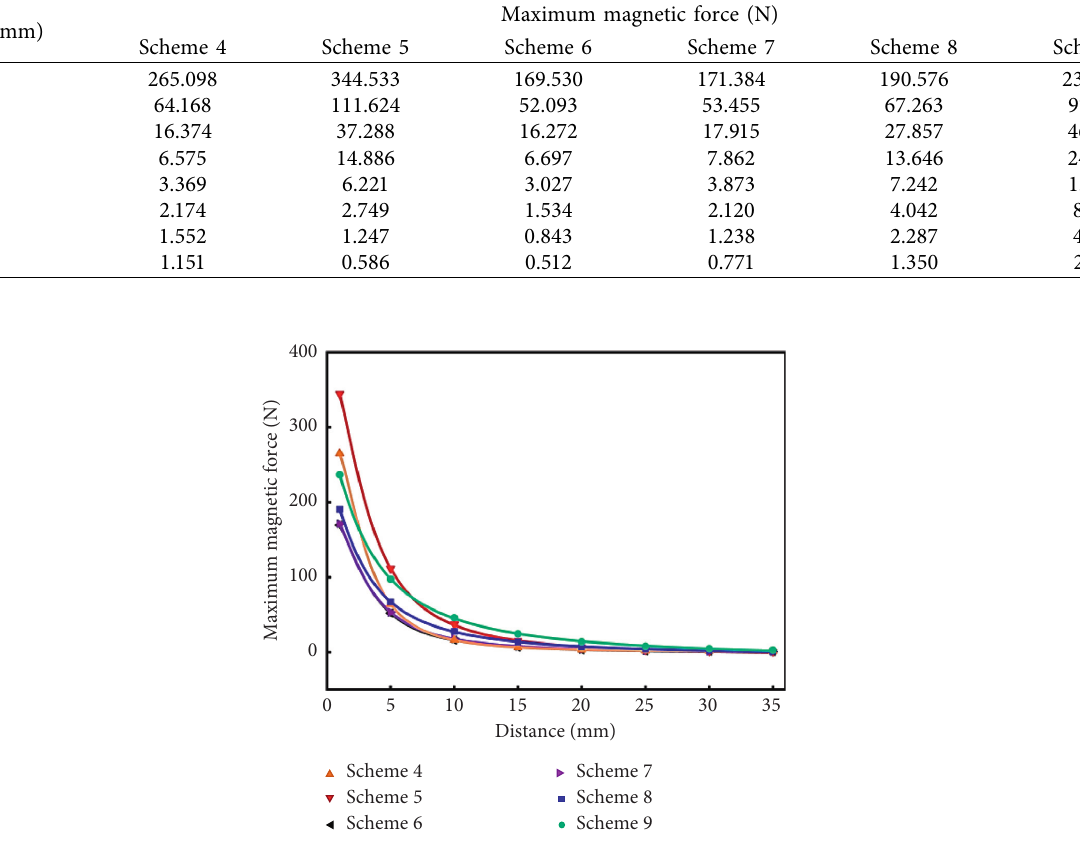
Figure 13: The curve of the relationship between the maximum magnetic force and distance when the valve seat consists of four identical shape tile